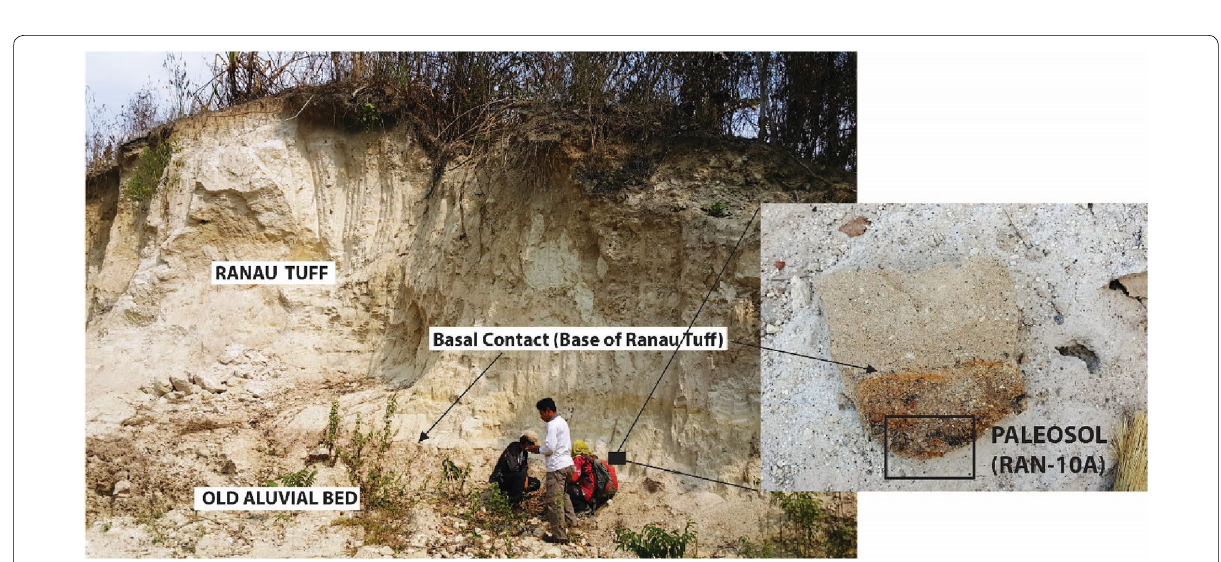
Fig. 8 Cliff exposure of the distal Ranau Tuff on the side of the road from Muaradua to Kisam (Lat,Lon: tive center, where samples RAN-10A was collected from a thin, brown